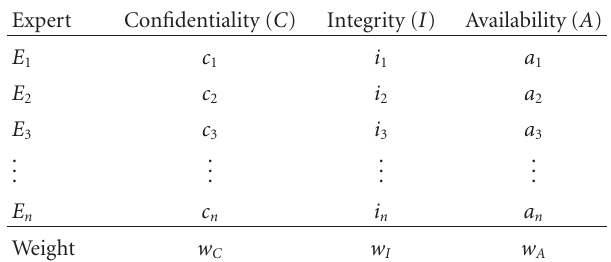
Table 8: CIA triad